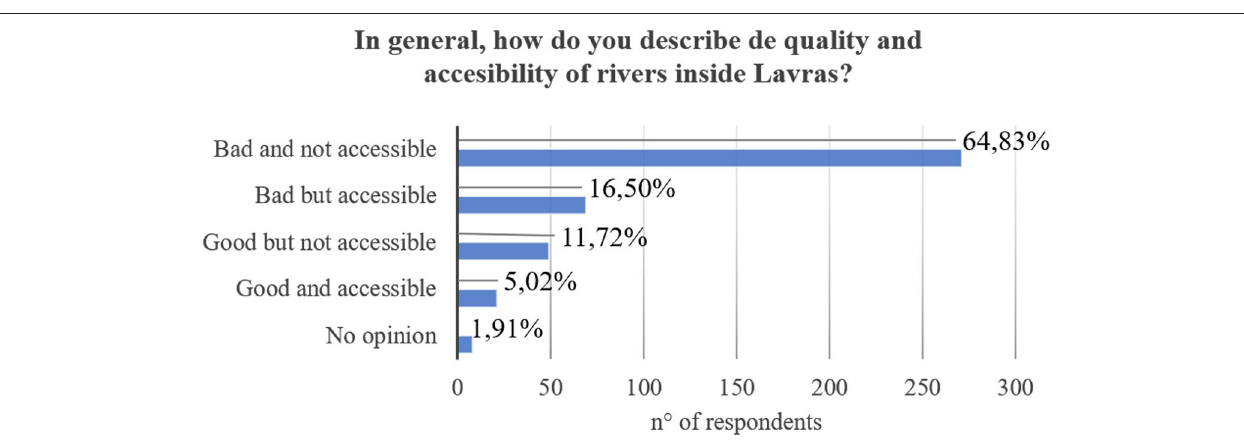
FIGURE 15 | Opinion on quality of and accessibility to streams of Lavras. Source: Sousa R. B. et al.